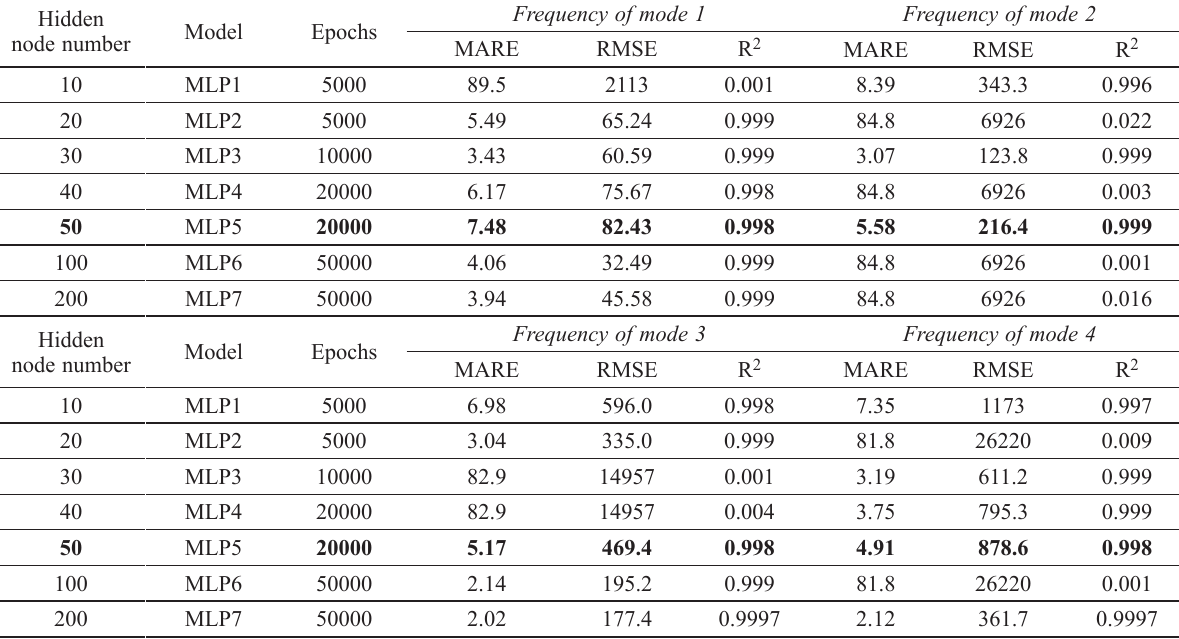
Table 2. The test results of the MLP models in natural frequency estimation Hidden node number